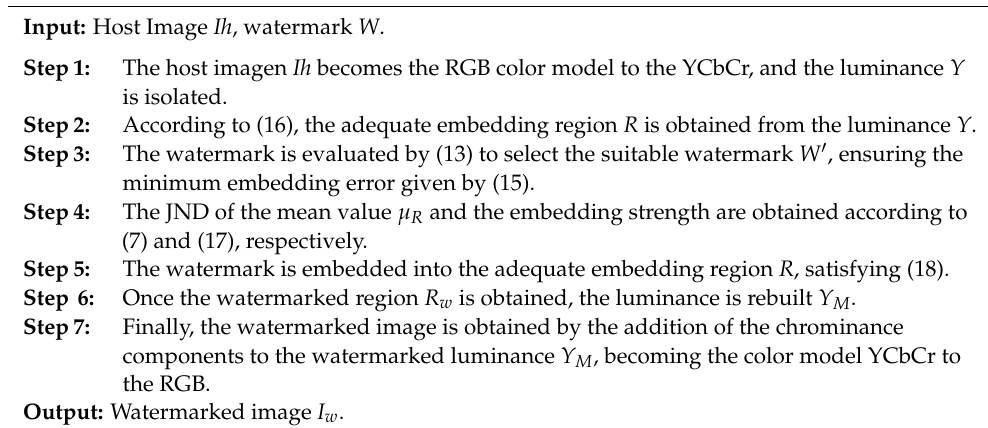
Figure 6. General diagram of the embedding stage. Algorithms 1. Embedding survey.